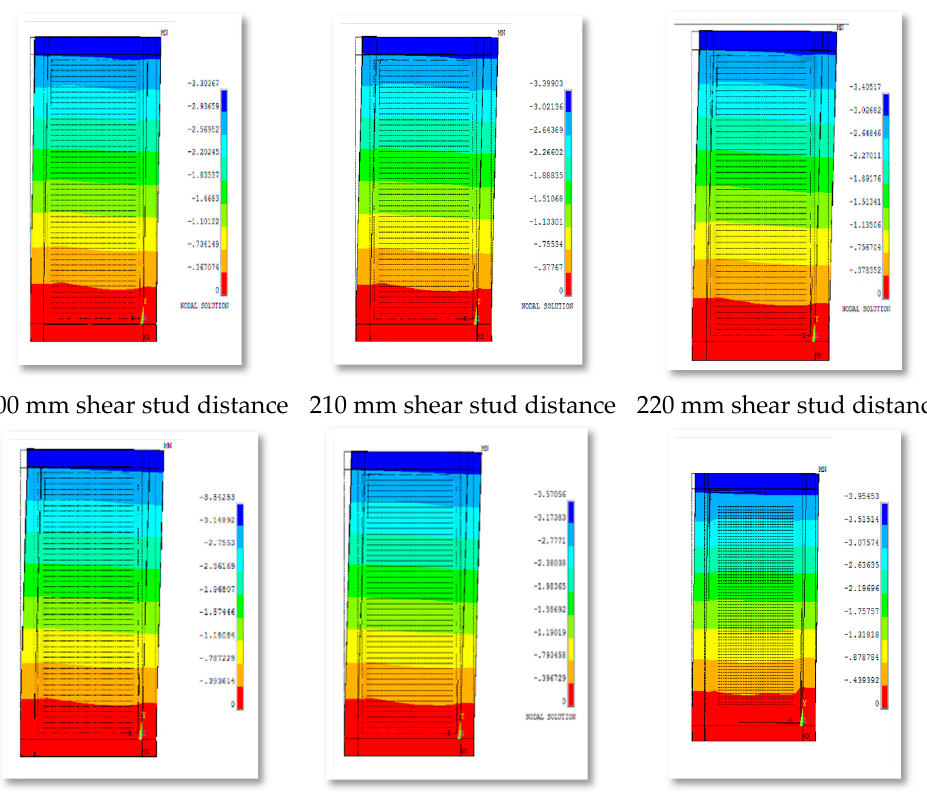
Figure 25. Out-of-plane displacement of group 4 for various shear stud distances.